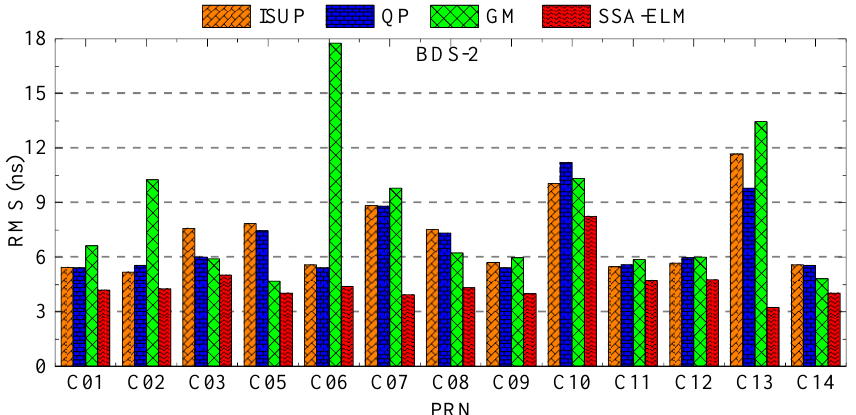
Figure 20. The initial residual value with a DOY of 198.